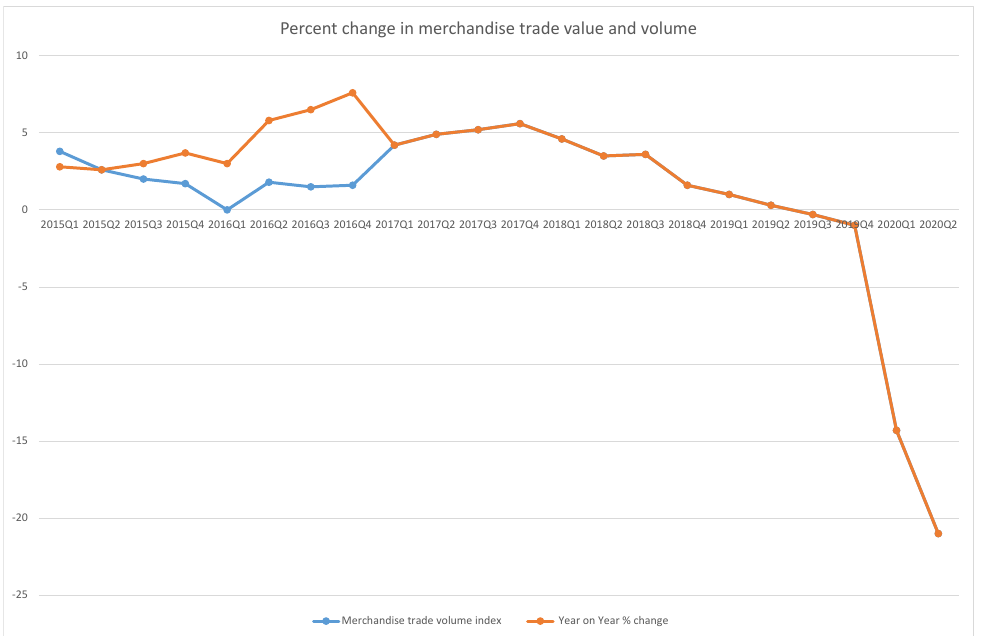
Figure 5. Percent change in merchandise trade value and volume